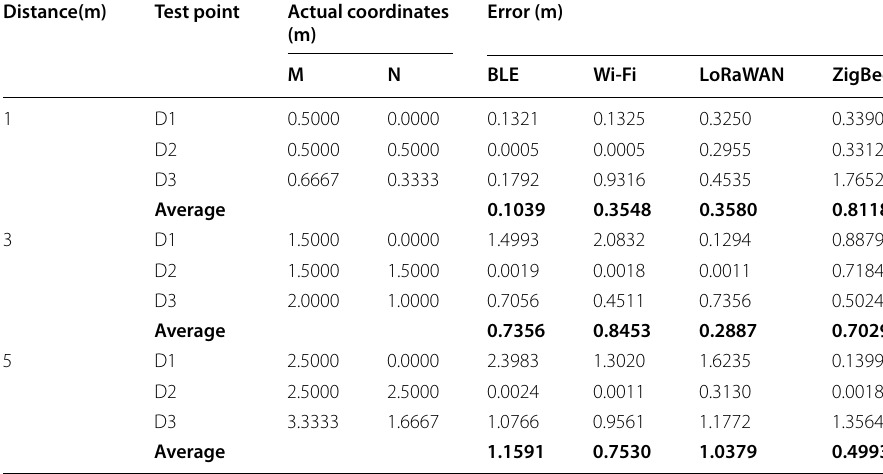
Table 4 MSE values with distances in environment 1 Distance(m) Test point Actual coordinates